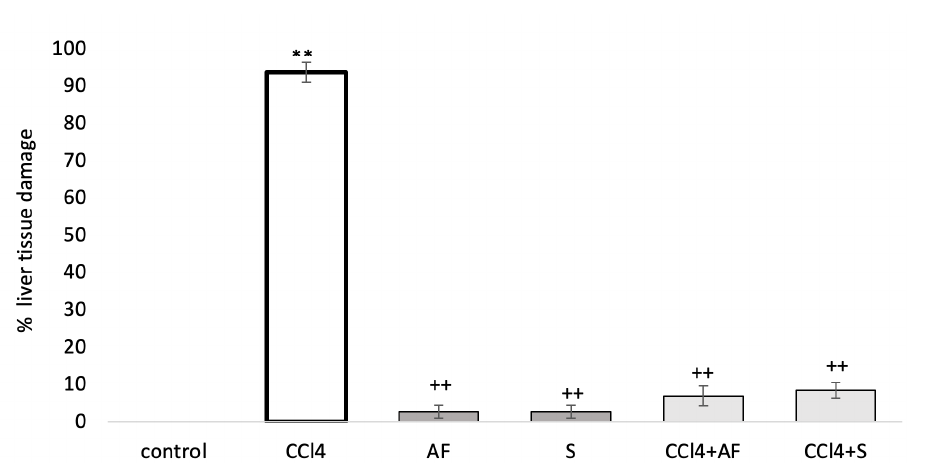
FIGURE 4 - Graphical representation of the histological analysis. ** p < 0.01 vs control (non-treated animals); ++ p < 0.01 vs CCl